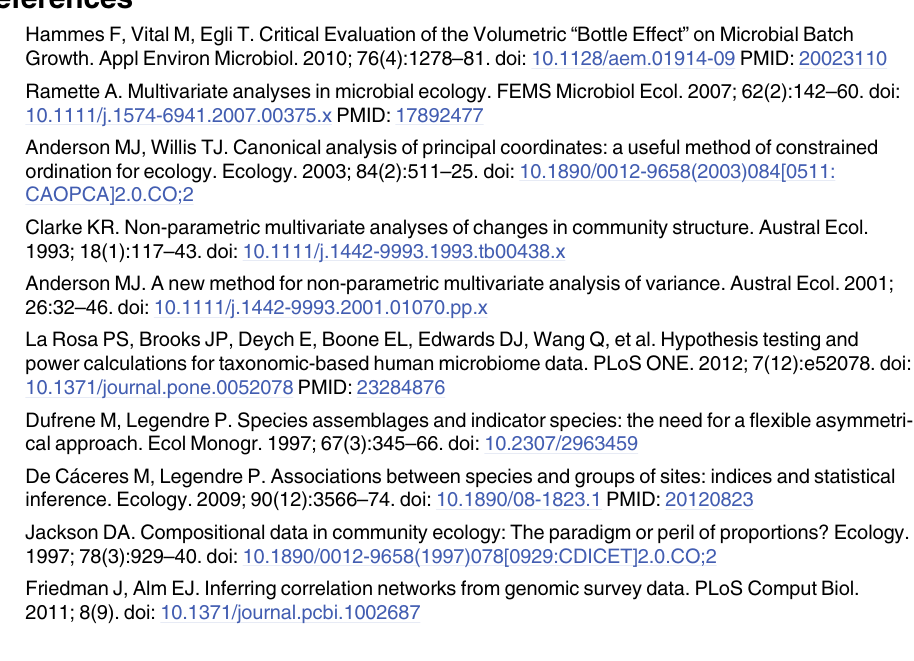
S2 Fig. OTU dynamics measured by Δ z . Each OTU present in the microcosm experiment described in the main text is shown. OTUs that meet the Δ z criterion described in the text ( Δ z in treatment > Δ z in treatment − 0.5) are in red. OTUs that meet the criterion and are among the 304 most abundant sequences in the four microcosm experiments (i.e., those shown as blue dots in Fig 4) are circled. OTUs with an undefined Δ z value in either microcosm are not shown, while OTUs with infinite Δ z values are shown at the border of the figure (e.g., an OTU with Δ z = + 1 in the control unit and - 1 in the experimental unit would be shown in the lower-left corner). S3 Fig. OTU dynamics measured by Δ F . Each OTU present in the microcosm experiment described in the main text is shown. OTUs that meet the Δ F criteria described in the text ( Δ F in treatment > 0.5; Δ F in treatment < 0.5) are in red. OTUs that meet those criteria and are among the 304 most abundant sequences in the four microcosm experiments (i.e., those shown as red dots in Fig 4) are